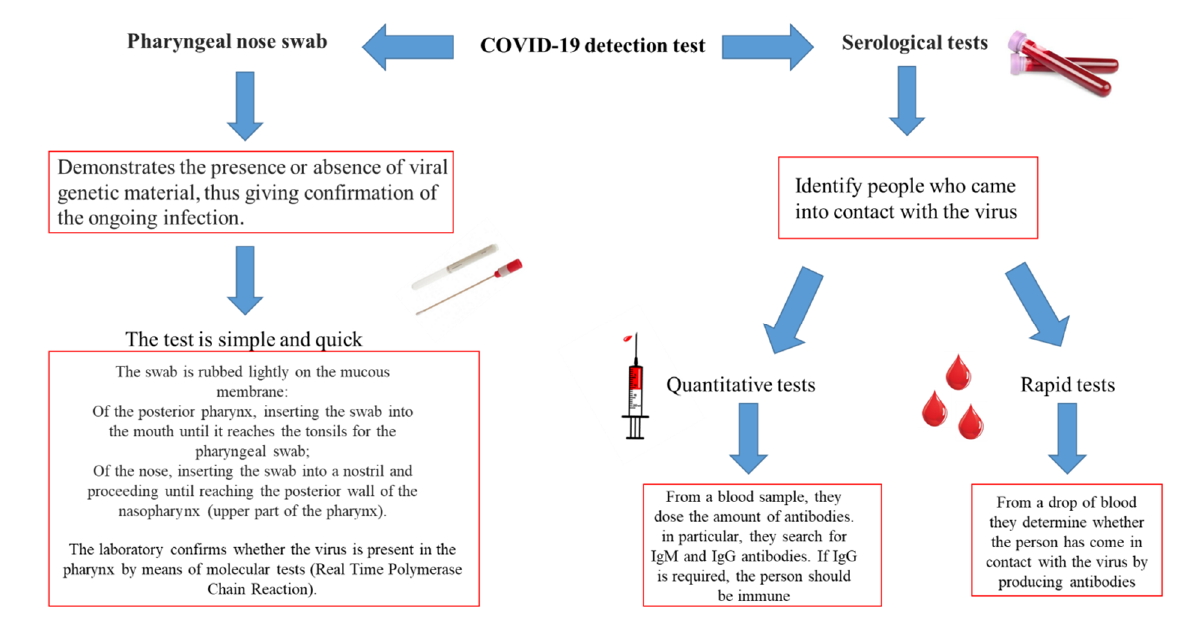
Figure 6. Diagnostic methods in use for the identification of COVID-19 infection.